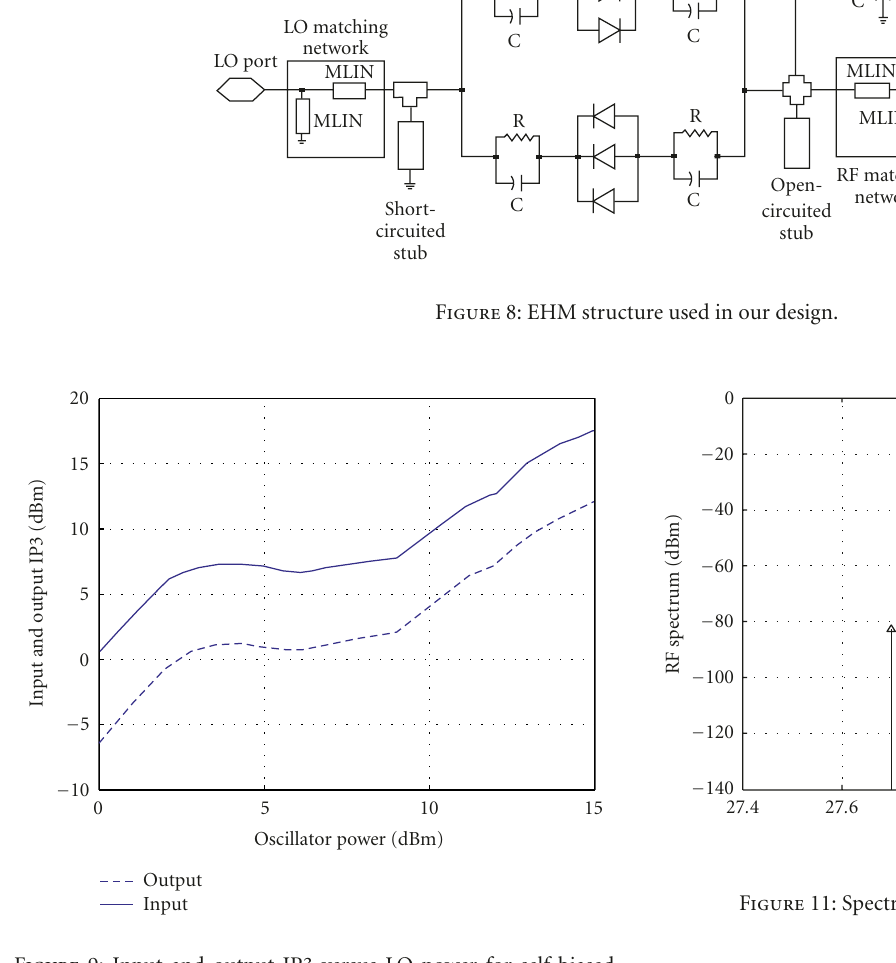
Figure 9: Input and output IP3 versus LO power for self-biased EHM.